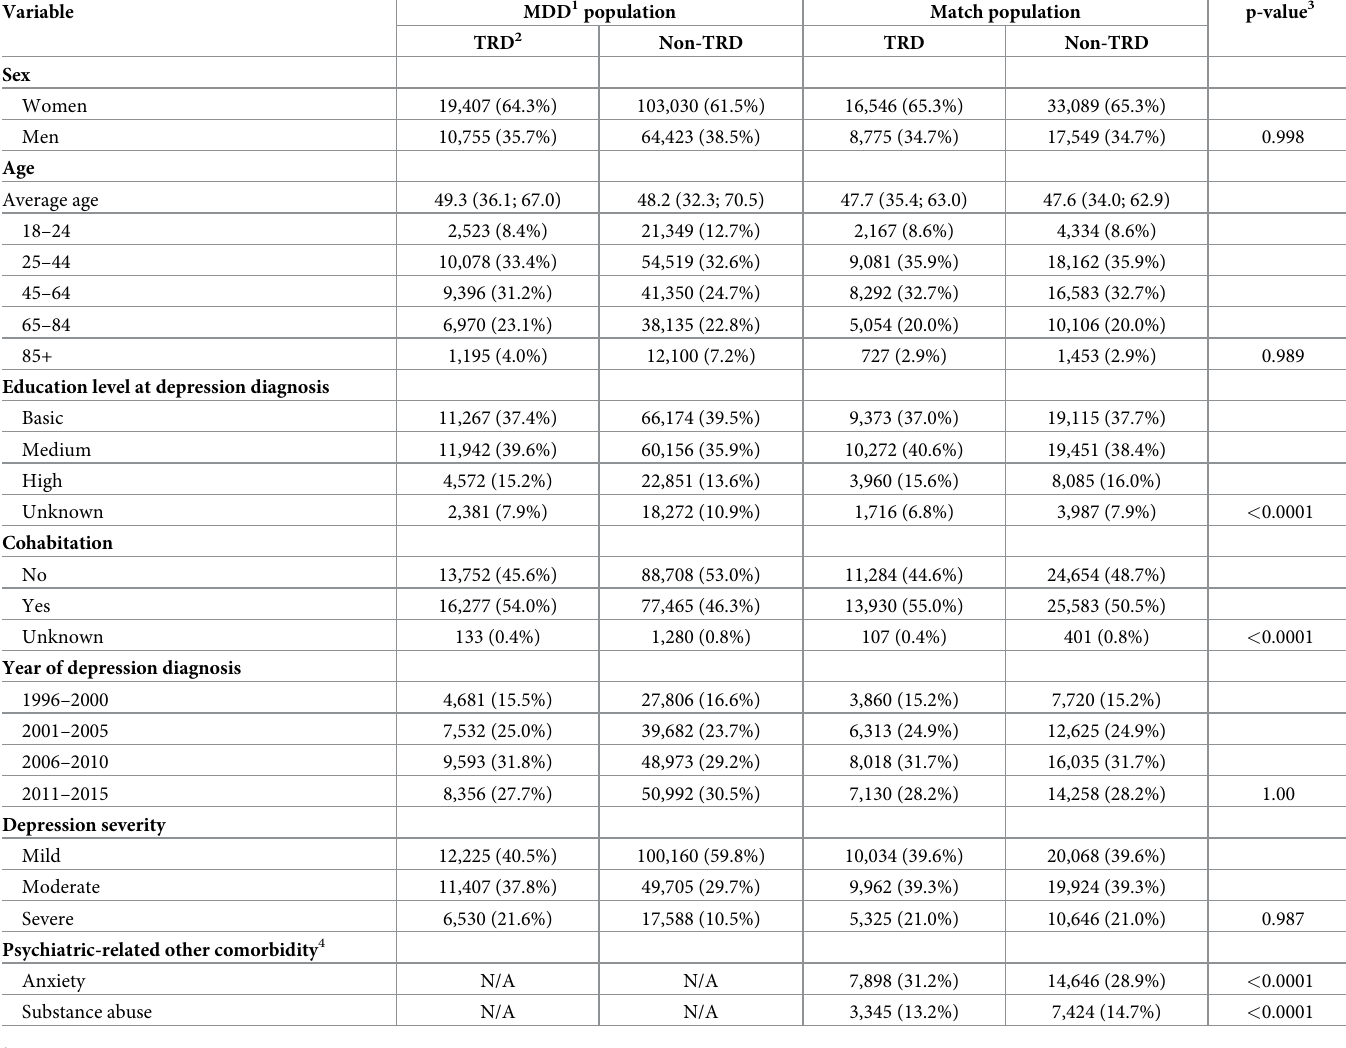
Table 1. Background characteristics of the TRD and non-TRD populations before and after